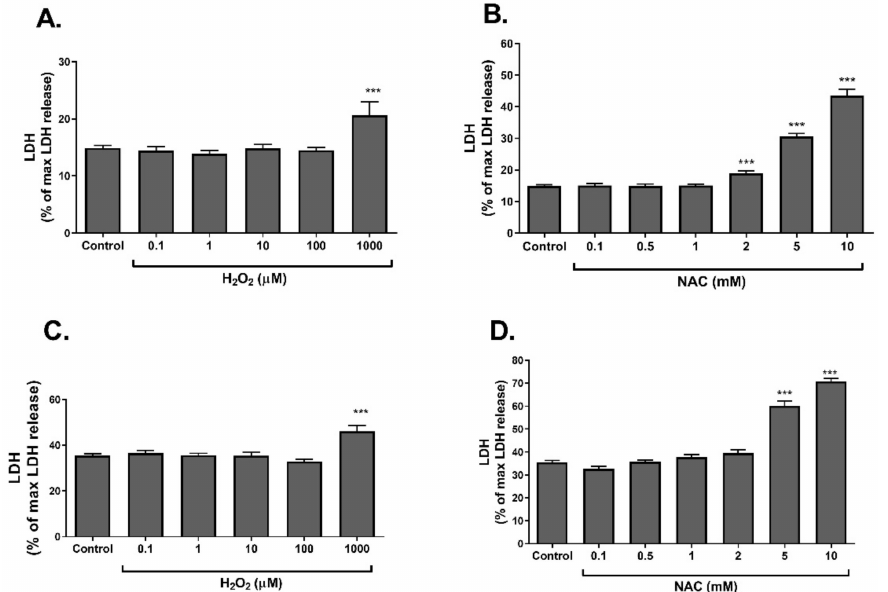
Figure 2. Cytotoxic effects of H 2 O 2 and NAC. L6 myotubes ( A , B ) and 3T3-L1 adipocytes ( C , D ) were treated with H 2 O 2 or NAC for 24 h. LDH release was measured as a biomarker of cytotoxicity, as described in Methods. The data represent the mean ± SEM of 4 independent experiments. *** p < 0.0005, compared to control, analyzed by one-way ANOVA, followed by Bonferroni’s post hoc testing.